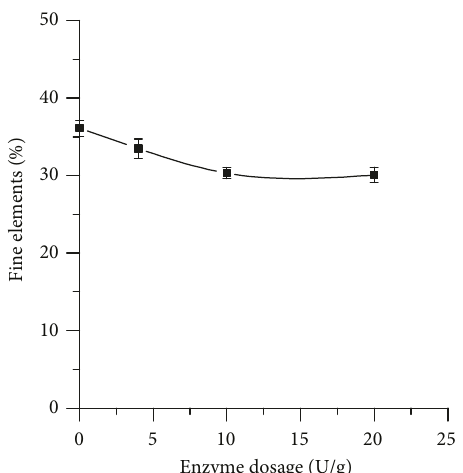
Figure 7: Effect of xylanase treatment on the coarseness of refiner mechanical fibers.